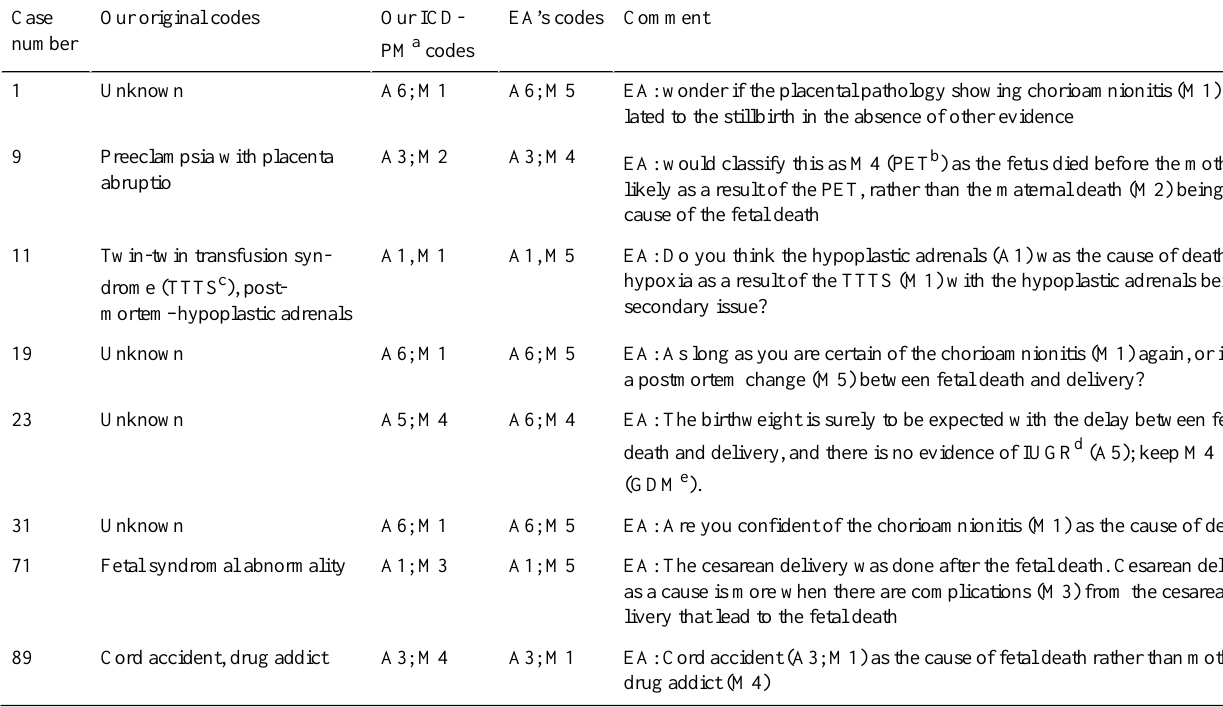
Table 1. The 8 cases in which the overseas expert (EA) disagreed with our codes.